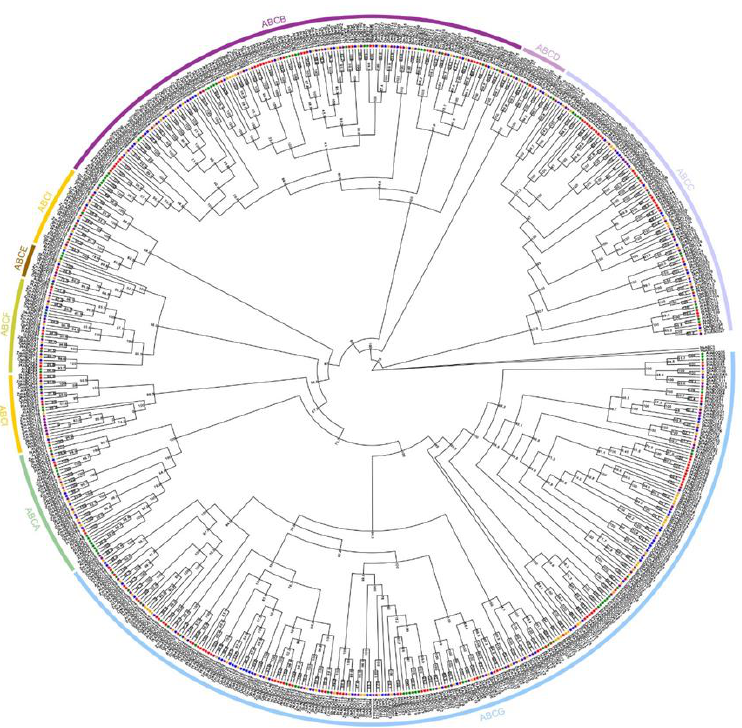
Figure 1. Evolutionary analysis of ABC family genes in maize cultivar B84 and other four different crops: Zm: Zea mays L.; Os: Oryza sativa L.; Sb: Sorghum bicolor (L.) Moench; At: Arabidopsis; Ptr: